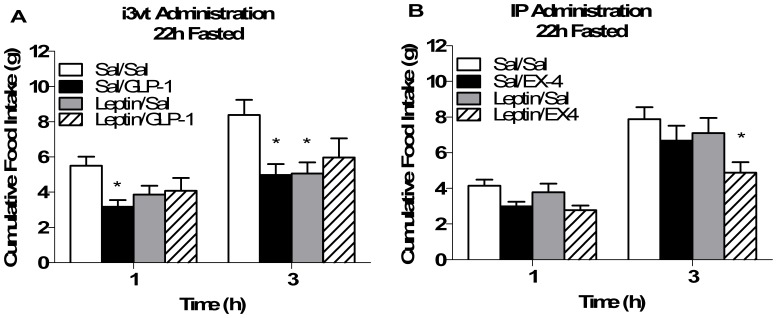
Interaction of the GLP-1 and leptin systems on food intake after fasting.a) 1 and 3 h food intake was suppressed in animals given i3vt GLP-1 and 3h food intake was suppressed by i3vt leptin (*p<0.05 vs. i3vt saline). There was no additive effect of giving GLP-1+ leptin on suppression of food intake in 22h fasted animals. White bar, i3vt saline+i3vt saline; black bar, i3vt saline+i3vt GLP-1; gray bar, i3vt leptin+ i3vt saline; hatched bar, i3vt leptin+i3vt GLP-1. b) 3 h food intake was suppressed by combined IP injections of EX4 and leptin. *p<0.05 in EX4+leptin vs. all other groups at the 3 h time point. White bar, i3vt saline+IP saline; black bar, i3vt saline+IP exendin-4; gray bar, i3vt leptin+IP saline; hatched bar, i3vt leptin+IP exendin-4.